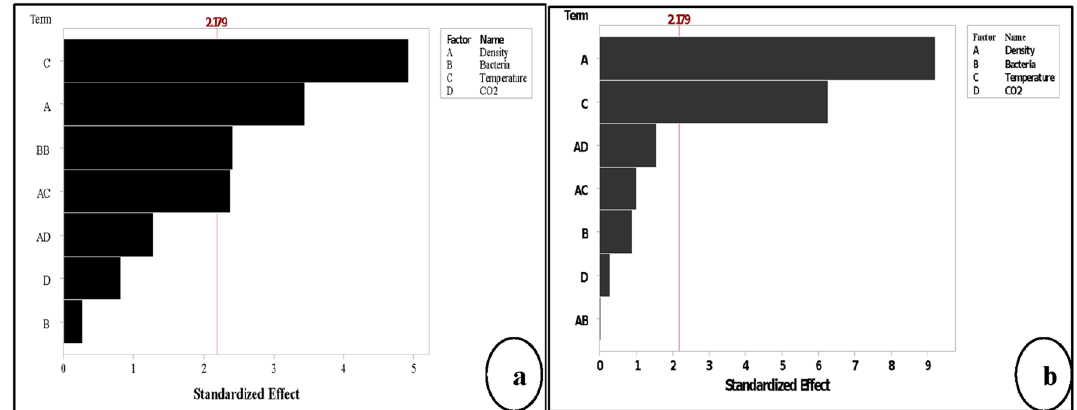
Figure 10. Pareto chart of the standardised effects by RSM analysis α = 0.05 ( a ) response is initial water absorption ( b ) response is water